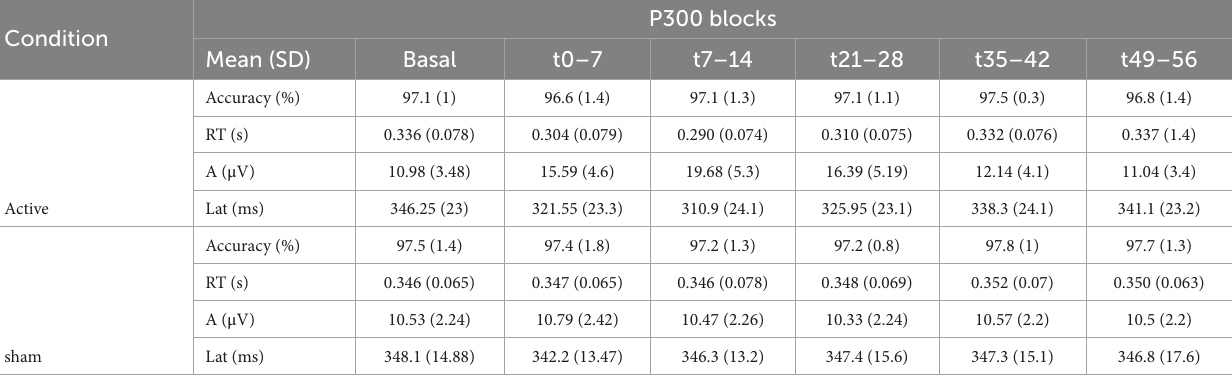
TABLE 2 Behavioral and electrophysiological results (mean values with their standard error) along the repeated blocks in active and sham condition are shown.